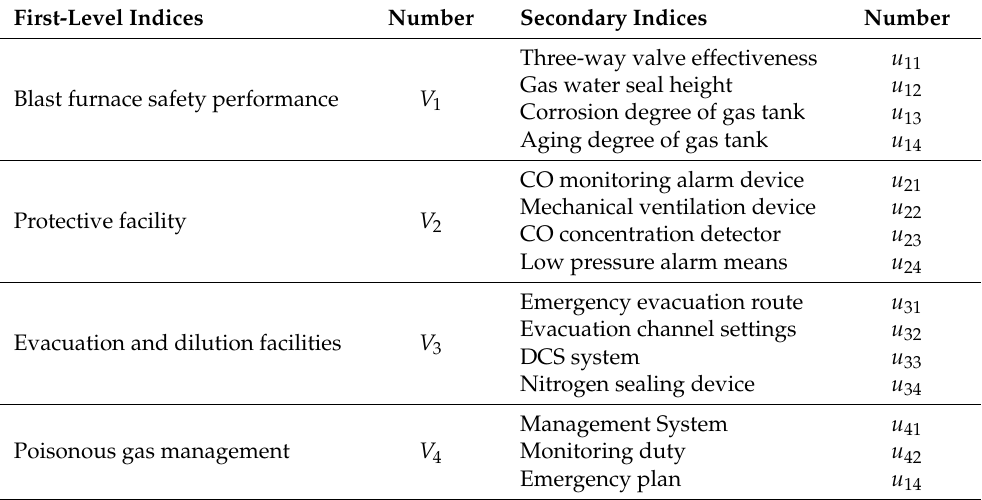
Table 1. Risk assessment index